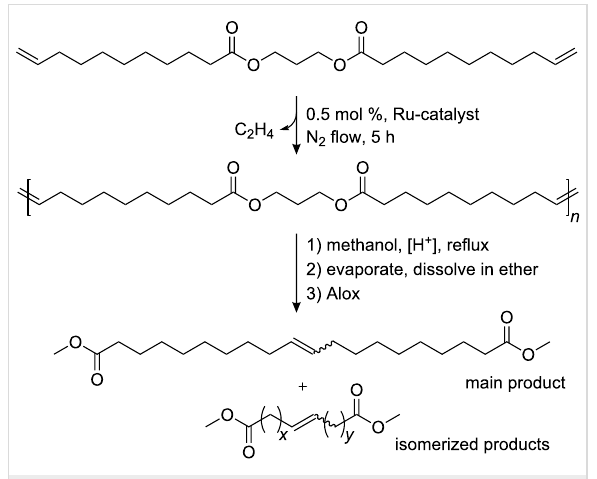
Figure 4: Synthesis of the studied α , ω -diene, its ADMET polymeriza- tion, and the strategy to evaluate isomerization side reactions.